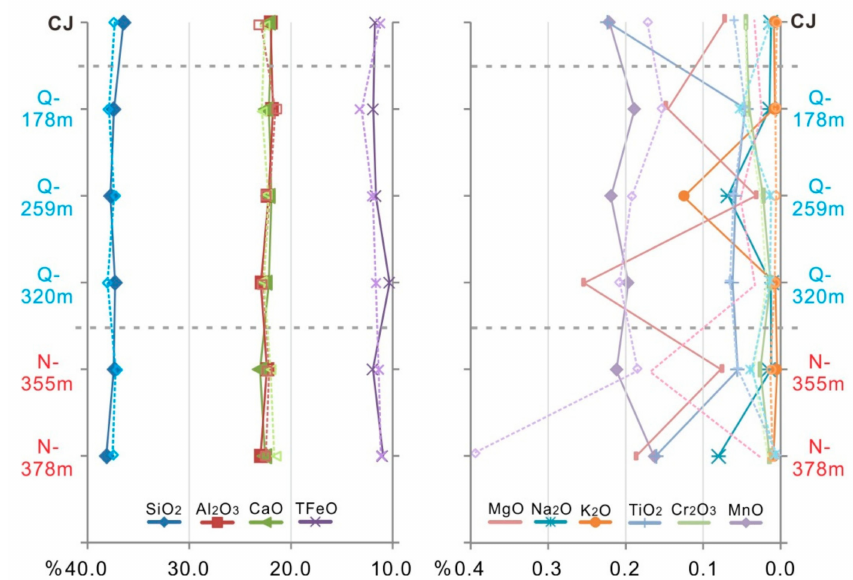
Figure 6. Mean element compositions of the epidote of Core LQ24 and the modern Changjiang River. A very fine sand fraction (63–125 µ m) is indicated by full lines and coarse silt (32–63 µ m) is indicated by dashed lines. Core depth is set in the vertical axis. CJ = Changjiang River. Core samples that were sampled from di ff erent depths of burial are marked in a red and light blue color. The red one is representative of the Pliocene; the light blue is representative of the Pleistocene; N = Pliocene, Q = Pleistocene. Please see Table 1 for the numbers of grains analysed per sample.